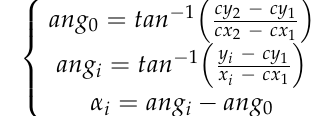
Figure 13. The angular state of the fist bolt corner to the reference line.